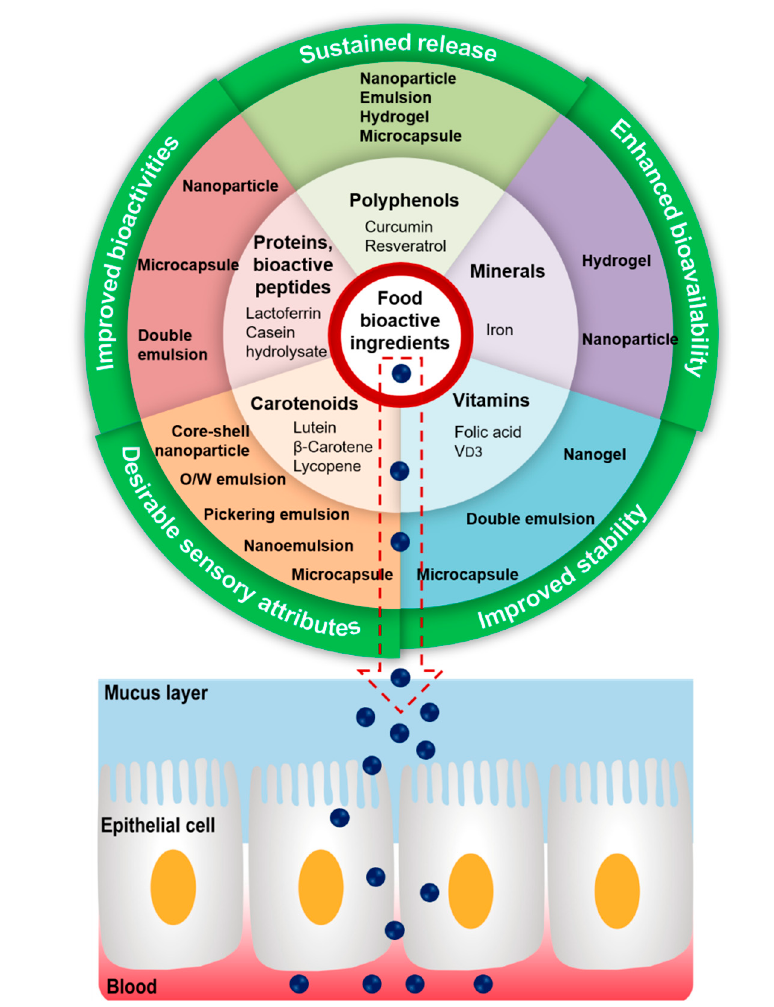
Figure 3. Summary of key points of discussion in Section 4. Considering the improved properties of loaded food bioactive ingredients, protein–polysaccharide-based delivery vehicles are promising approaches for enhancing cellular uptake and achieving systematic